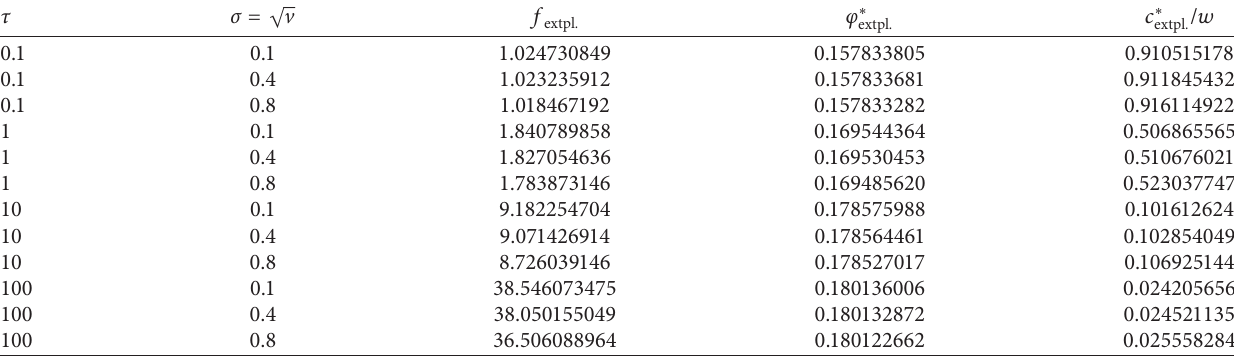
Table 15: Numerical solutions for f, φ ∗ , and c ∗ / w after performing Richardson’s extrapolation. Here, α � 0 . 5, c � 10, and Δ τ � Δ v � 0 . 001. Other parameter values are the same as those in Table